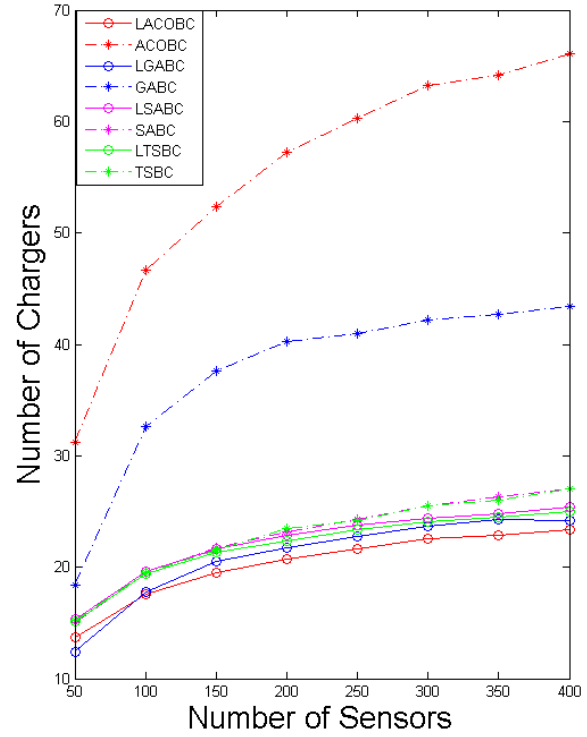
Figure 3. Comparison of the number of chargers.